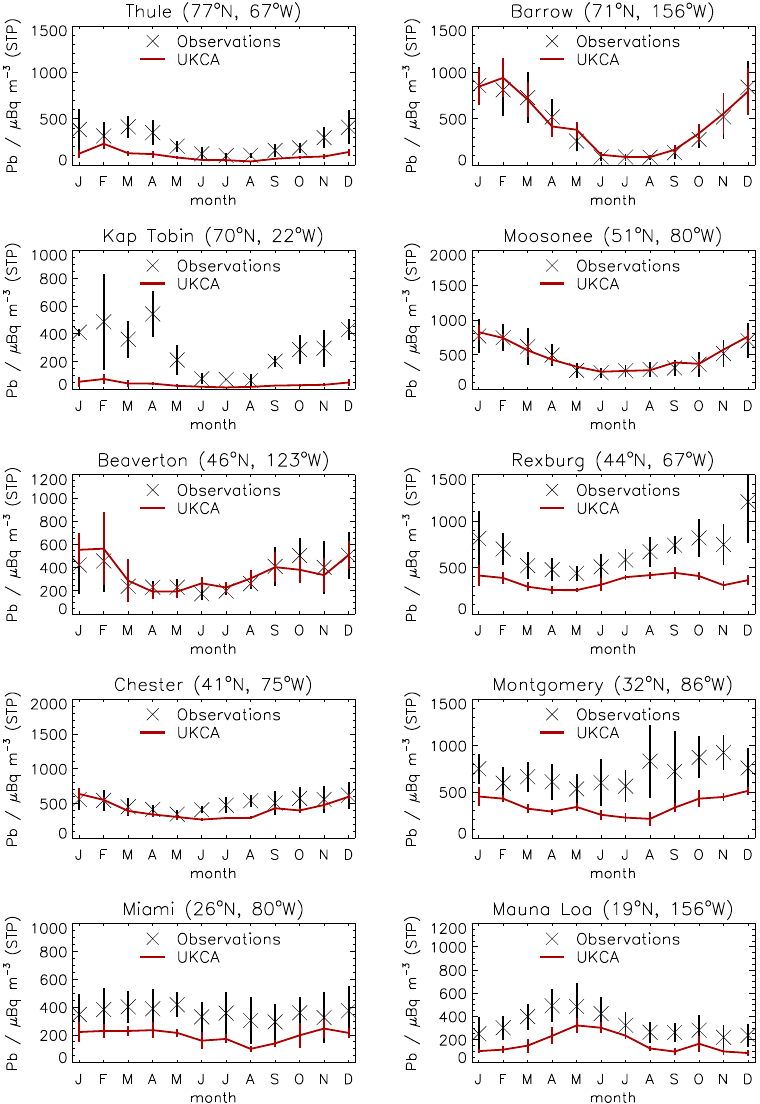
Fig. 5. Comparison of modelled surface lead concentrations in units of µBqm − 3 (STP) with surface observations for a number of sites in the Northern Hemisphere. Observations are shown as black crosses and the UKCA model is shown in red. Measurements are taken from the Surface Air Sampling Program database of the Environmental Measurements Laboratory (EML) (http://esd.lbl.gov/research/facilities/eml/). shows the comparison of HadGEM2-UKCA with the ob- served profiles over these regions. Given that the model is not running with the specific meteorology associated with PEM West-B, the comparison is only intended to be a gen- eral comparison of the calculated profiles. However, it is ex- pected that the measured profiles lie within the variability (spatial and temporal) of the modelled profiles. For the “re- mote Pacific”, HadGEM2-UKCA matches the absolute mean 210 Pb concentrations and the shape of the observed pro- file particularly well. In particular, scavenging during PEM- West B was dominated by dynamic scavenging (Guelle et